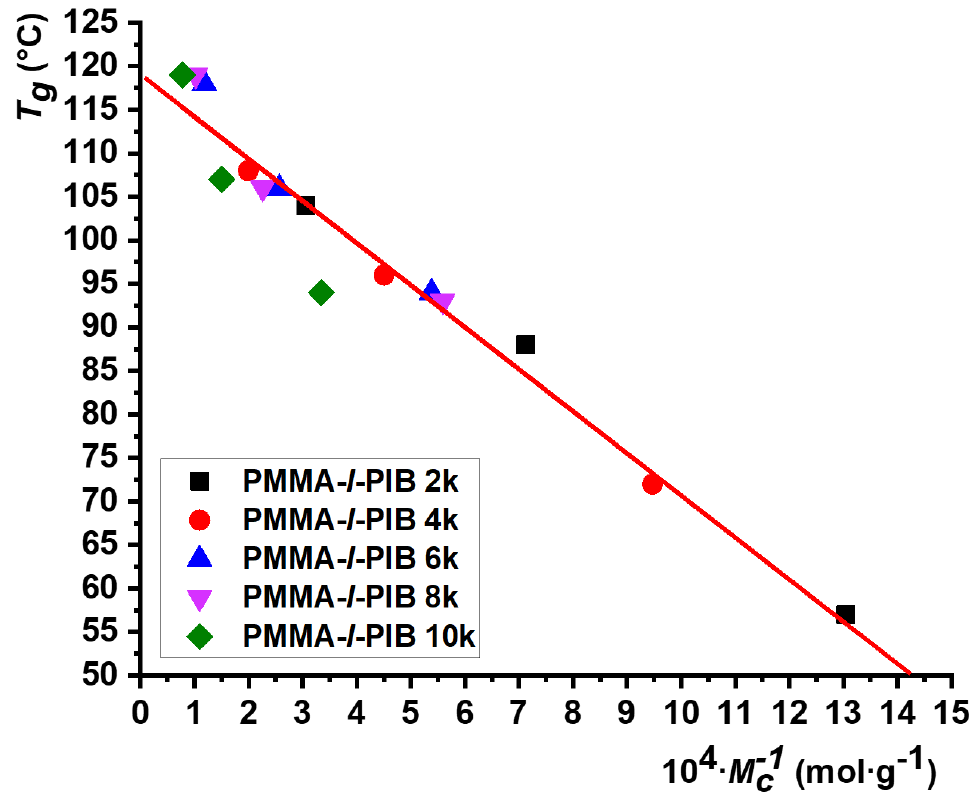
Figure 3. The Fox–Flory plot of the glass transition temperatures: T g s of the PMMA component as a function of 1/ M c in the PMMA- l -PIB conetworks.